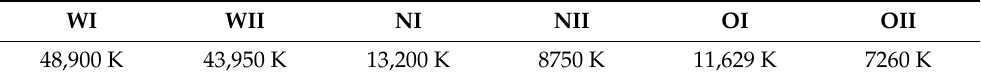
Table 1. The electronic excitation temperature of the excited neutral atoms and ions species.